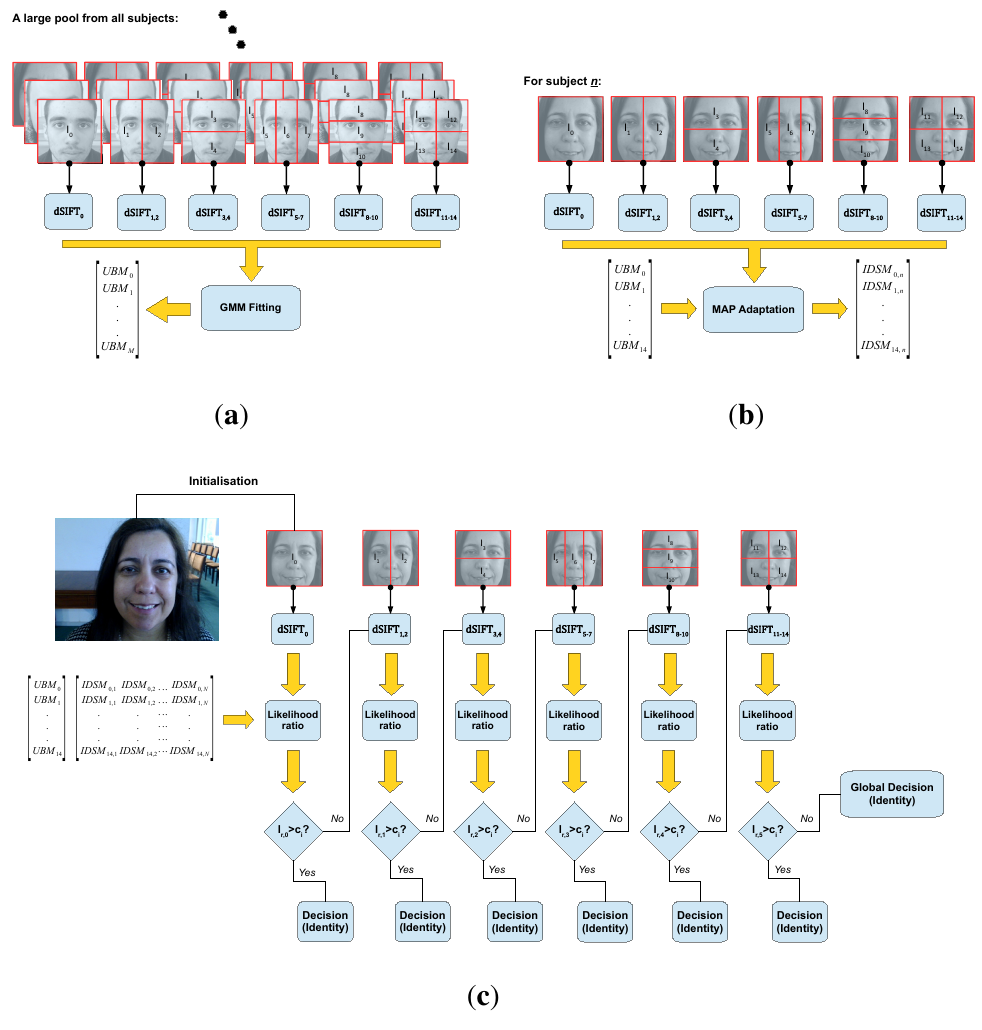
Figure 1. Schematic representation of the proposed algorithm and its main blocks: ( a ) training of the universal background models using data from multiple individuals; ( b ) maximum a posteriori (MAP) adaptation of the universal background models (UBM) to generate individual specific models; and ( c ) testing with new data from unknown